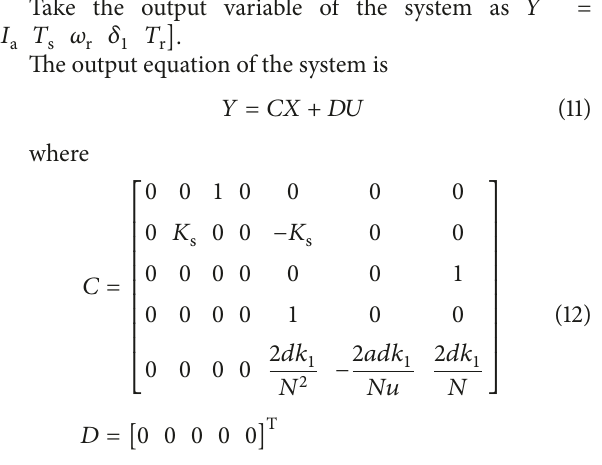
Take the output variable of the system as 𝑌 = 𝑇 𝜔 𝛿 𝑇 [𝐼 ] . a s r 1 r